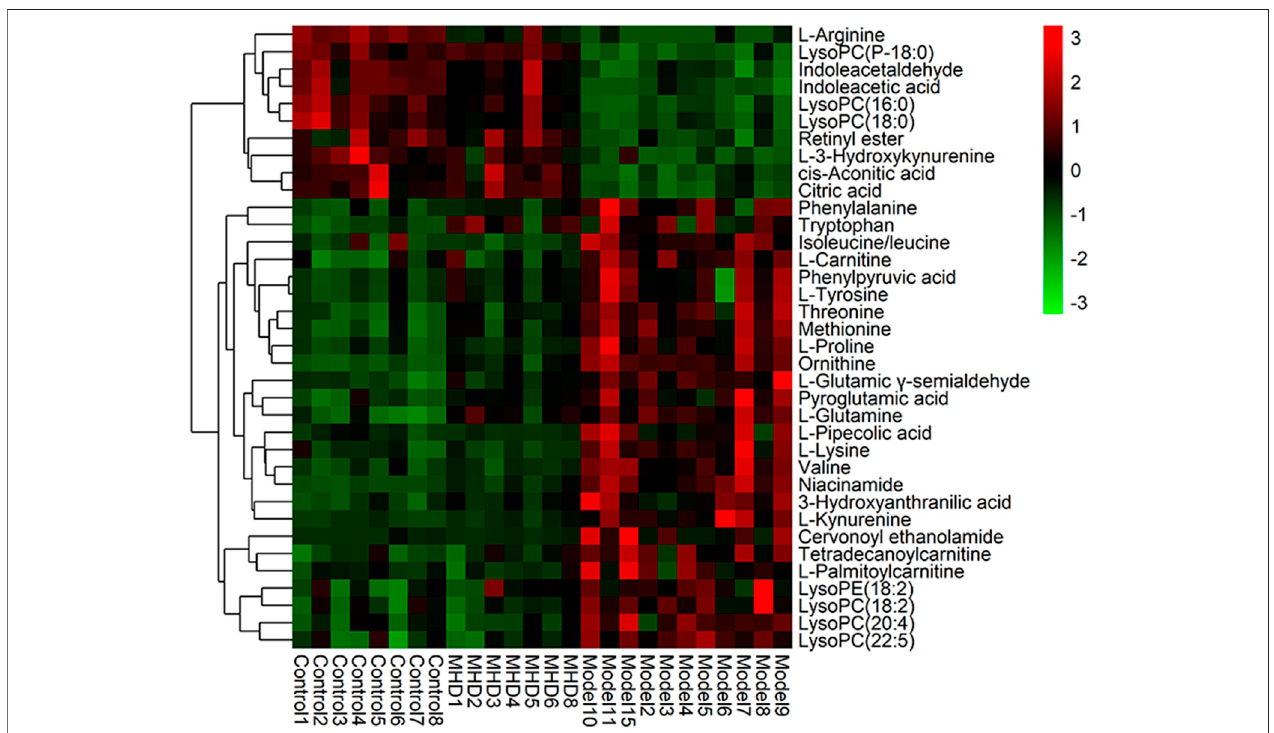
FIGURE 4 | Heatmap of the protective activity of MHD for ALF. The degree of change is marked with different colors. Red and green indicate up-regulation and down-regulation respectively. Each row represents a metabolite. Each column represents an individual sample.